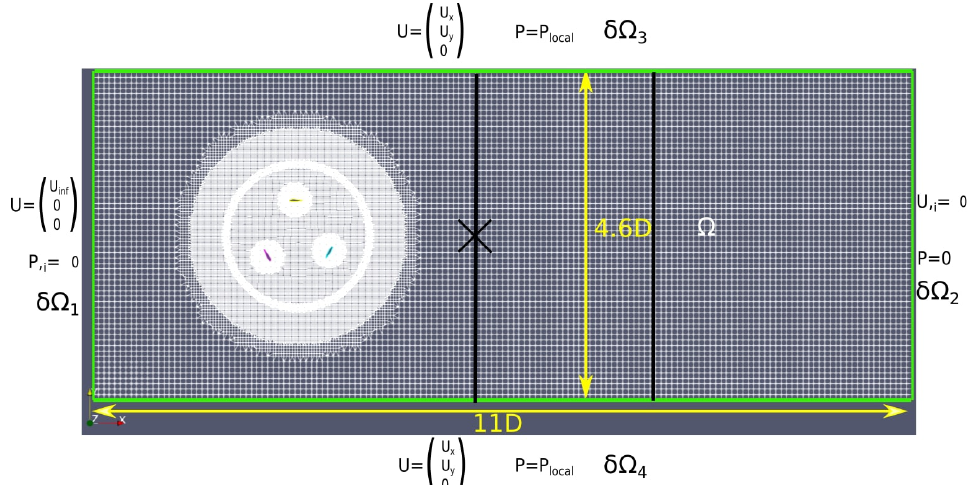
Figure 12. View of X–Y plane for the computational domain with boundary conditions (in green). D is the rotor’s diameter in m. U is the flow velocity in m · s − 1 , and P is the pressure in Pa. The two black lines (2D and 4D) and the black cross are the extraction lines and the probe, respectively, used in the model validation in Section